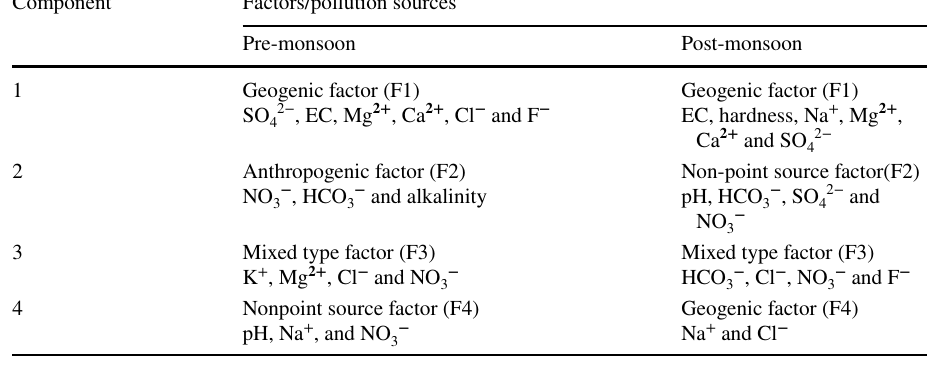
components incorporated in the interpretation of pollution sources (pre- and post- monsoon)